Question: Describe this figure in one sentence.
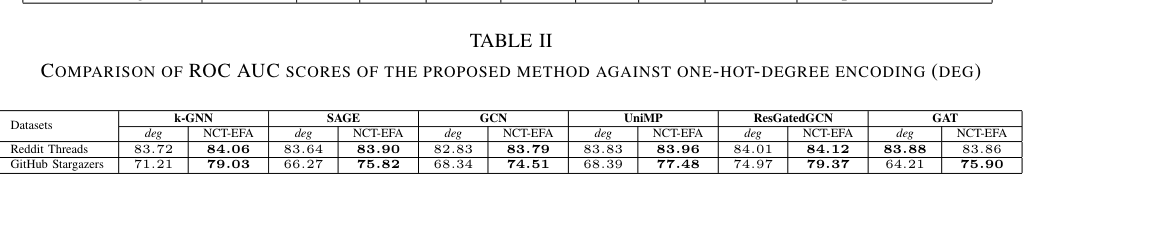
Answer: Comparison of ROC AUC scores of the encoded ranks (average controllability) against degree one-hot-encoding.